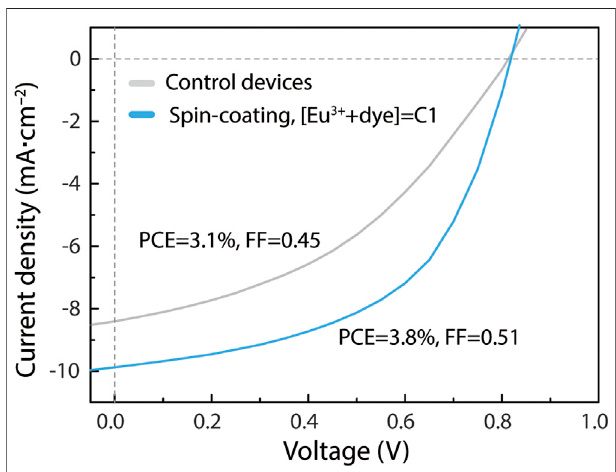
FIGURE4| J-Vcharacteristics ofdU6Eu/glass/ITO/PEDOT:PSS/PTB7- Th:ITIC/Ca/Al devices for which an improvement in PCE of ca. 22% was obtained in comparison with control devices.